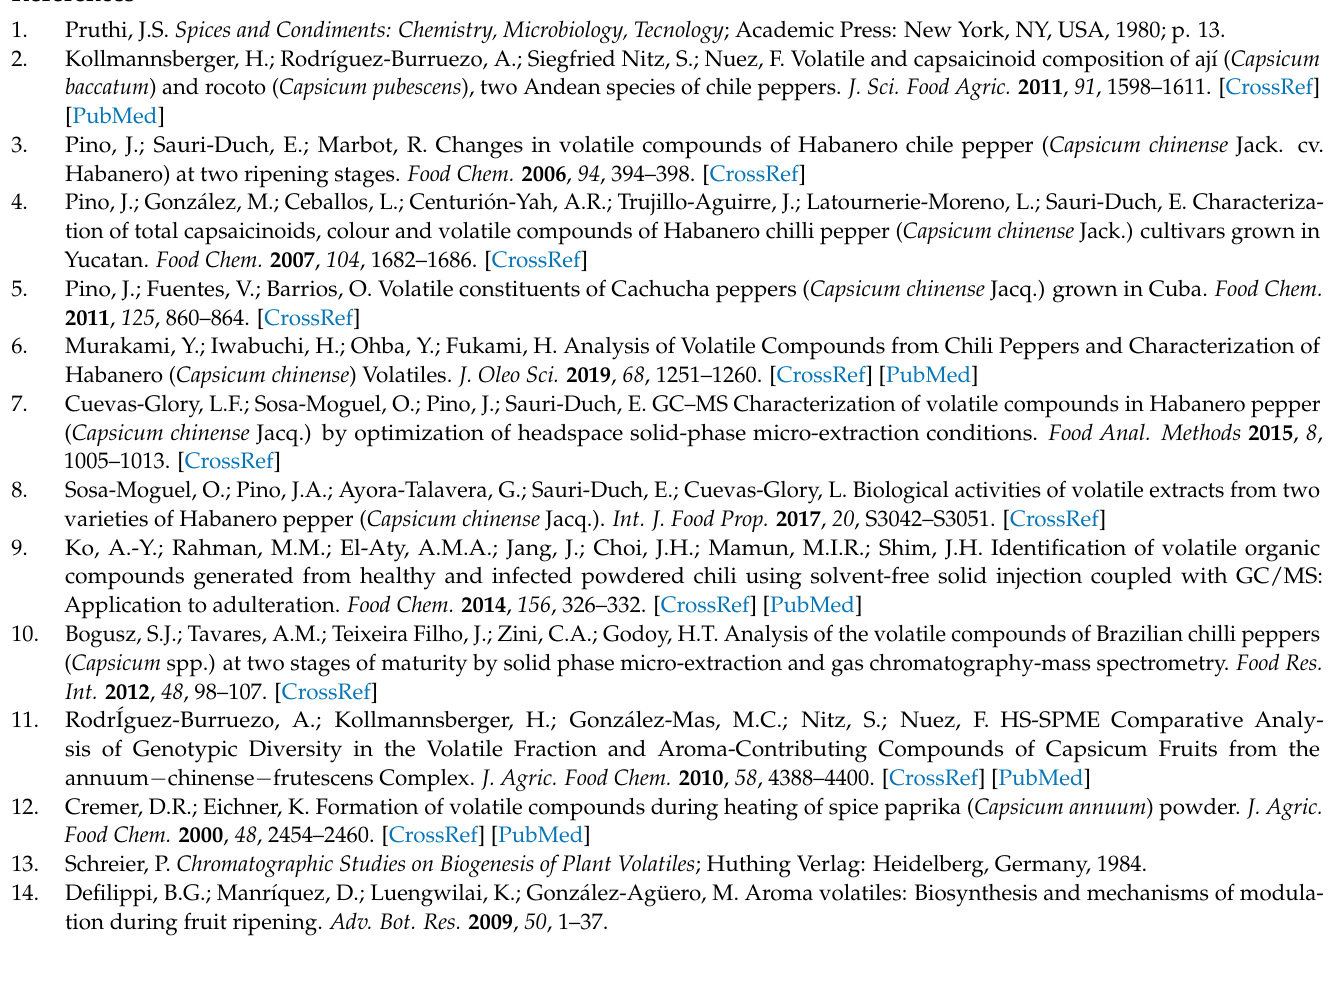
Table S4. Contribution of the variables on PC1 and